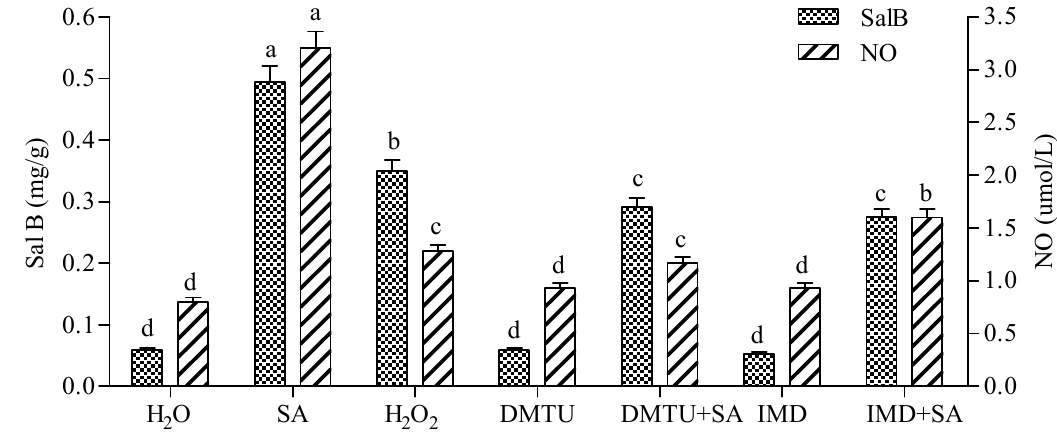
Figure 4. Effects of SA, exogenous H production of Sal B and NO in Salvia miltiorrhiza cell cultures. The concentrations for SA, O , IMD, CAT and DMTU were the same as Figure 1. The detection time for H 2 2 determining both contents of NO and Sal B was the same as Figure 3. Different lowercase letters represented significance at